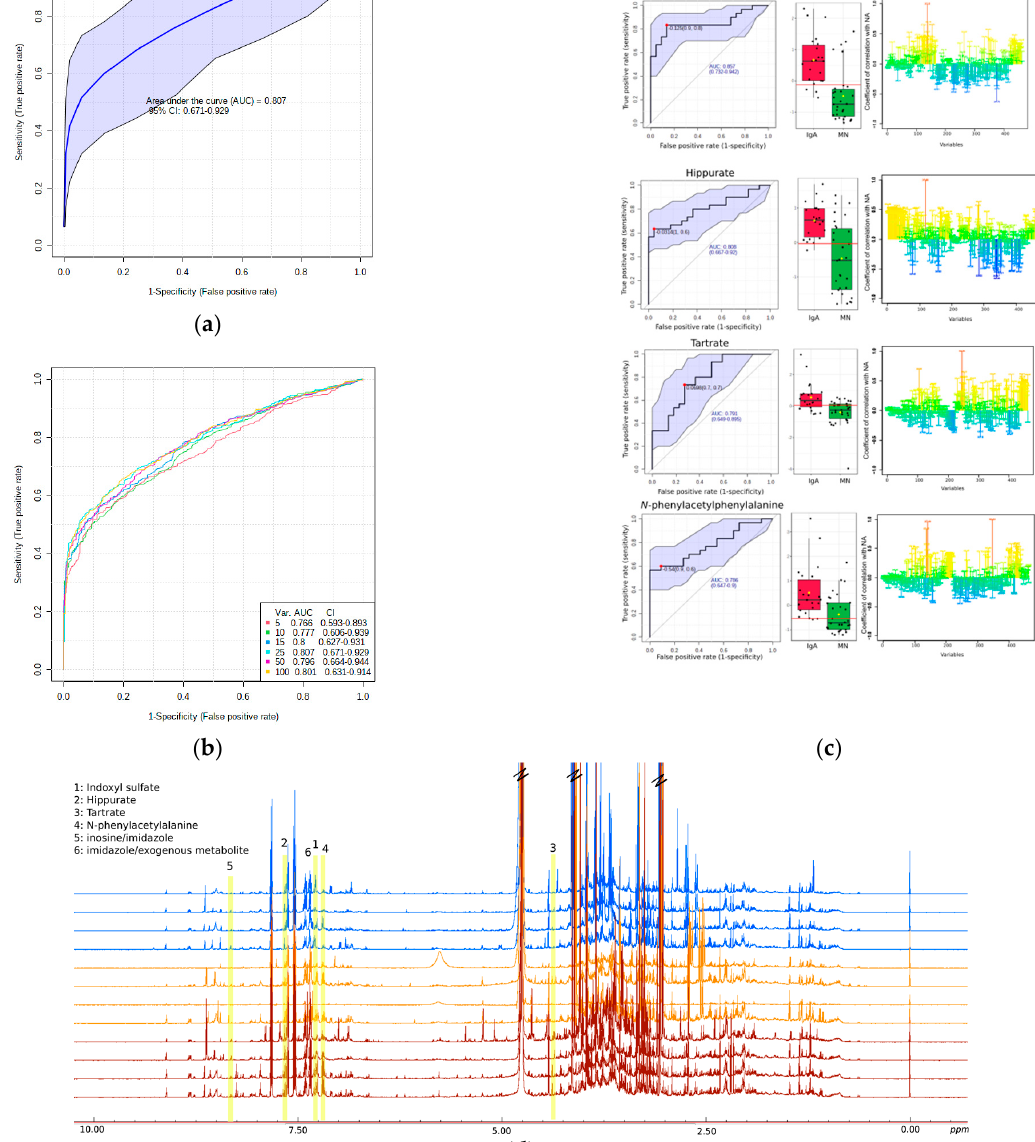
Figure 2. ( a ) The ROC curve computed based on all the 25 features with the 95% confidence interval; ( b ) Multivariate receiver operating characteristic (ROC) analysis, showing the feature numbers the AUCs and the confidence intervals of the six models and; ( c ) The top four biomarker candidate metabolites identified based on ROC curve analysis performed with all 25 urine metabolic features. The computed 95% confidence interval (CI) for individual marker metabolites is highlighted in the faint blue background over the ROC curve. The area under the receiver operating characteristic curve (AUROC) is shown in red to highlight the diagnostic potential of corresponding metabolite. The box-cum-whisker plots shown on the right side of each ROC curve plot revealed significantly increased urine levels of these metabolites in the IgAN patients compared to MN. For each metabolite the representative 1D STOCSY pseudo-NMR spectrum of correlation coefficients to the other signals in the median urine NMR spectrum and maximum intensity correlation of peaks are color encoded and projected into statistical difference spectra; ( d ) Representative 1 H CPMG NMR spectra of urine samples of MN (blue spectra), IgAN (brown spectra) patients and healthy controls (orange spectra) and the corresponding metabolites of interest ( 1 H NMR signals) highlighted in